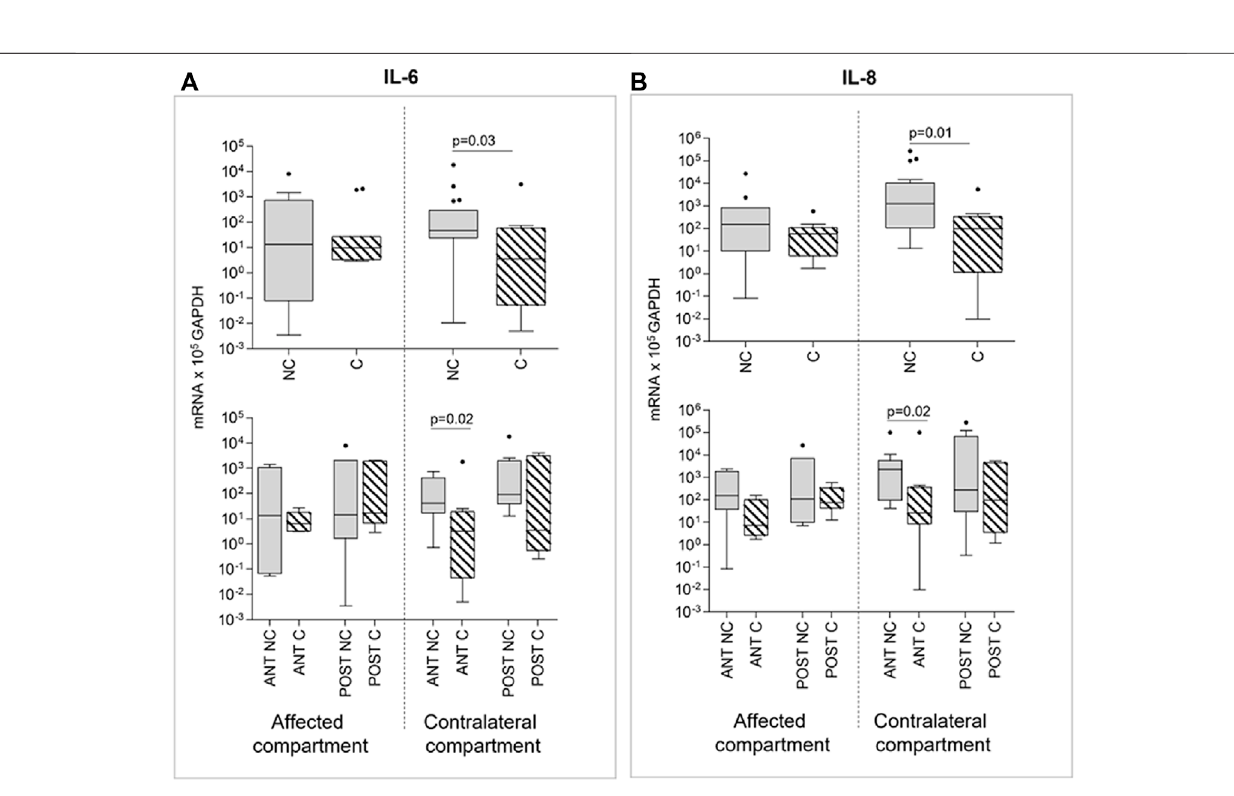
Frontiers in Bioengineering and Biotechnology |